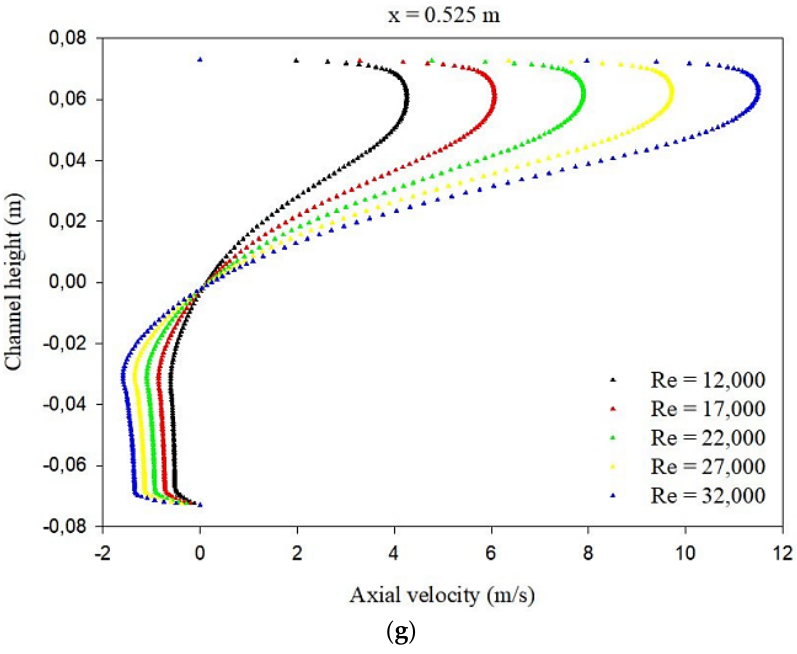
Figure 12. Changes in the axial velocity vs. Re for several locations within the channel: ( a ) x = 0.159 m; ( b ) x = 0.189 m; ( c ) x = 0.255 m; ( d ) x = 0.285 m; ( e ) x = 0.315 m; ( f ) x = 0.345 m; ( g ) x = 0.525 m.